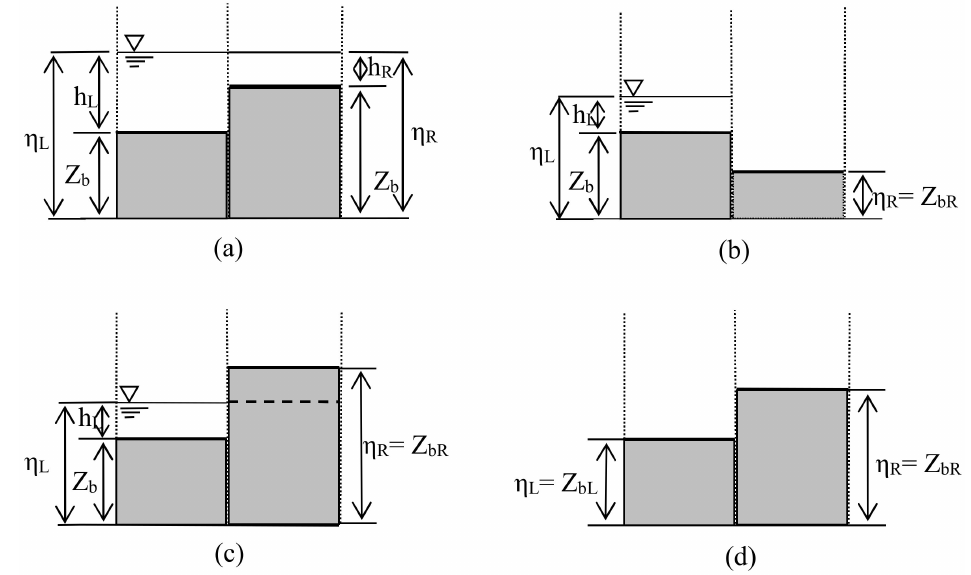
Figure 1. Schematic diagram of wet-dry